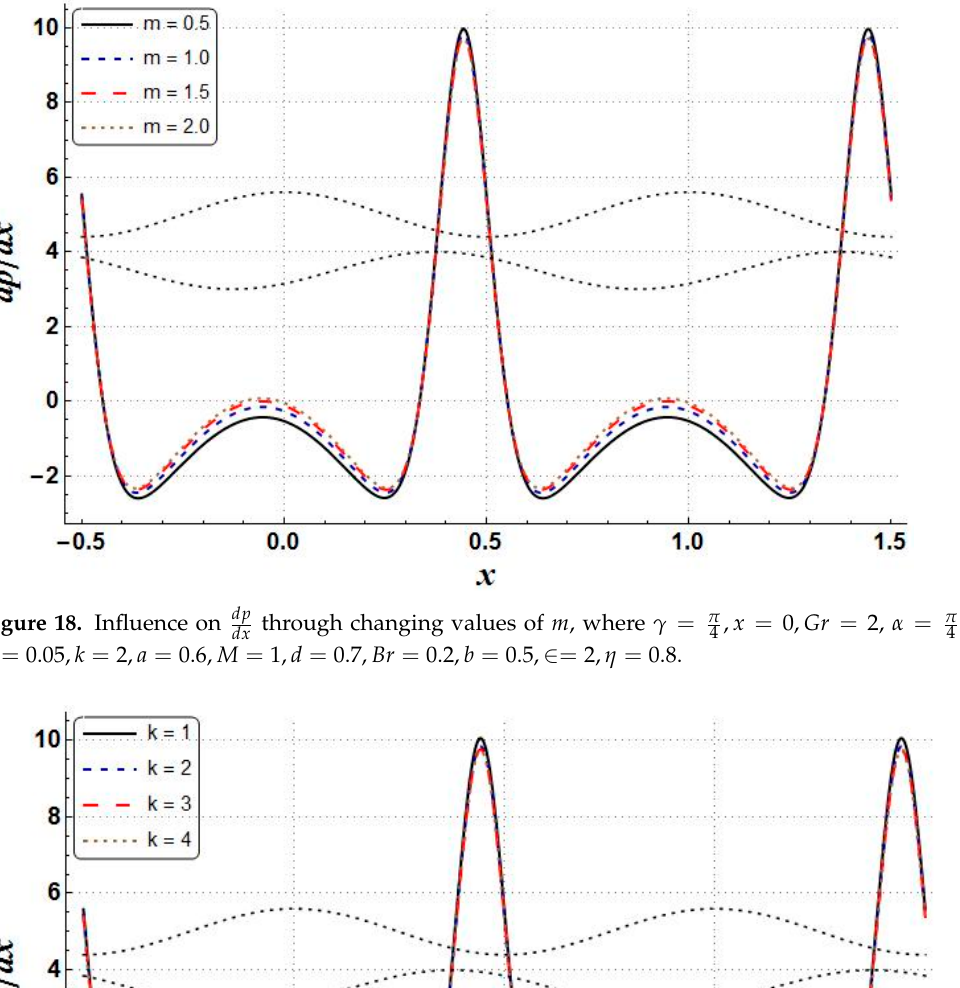
Figure 19. Influence on dp φ = 0.05, m = 1, a = 0.6, M = 1, d = 0.7, Br = 0.2, b = 0.5, ∈ = 2, η =